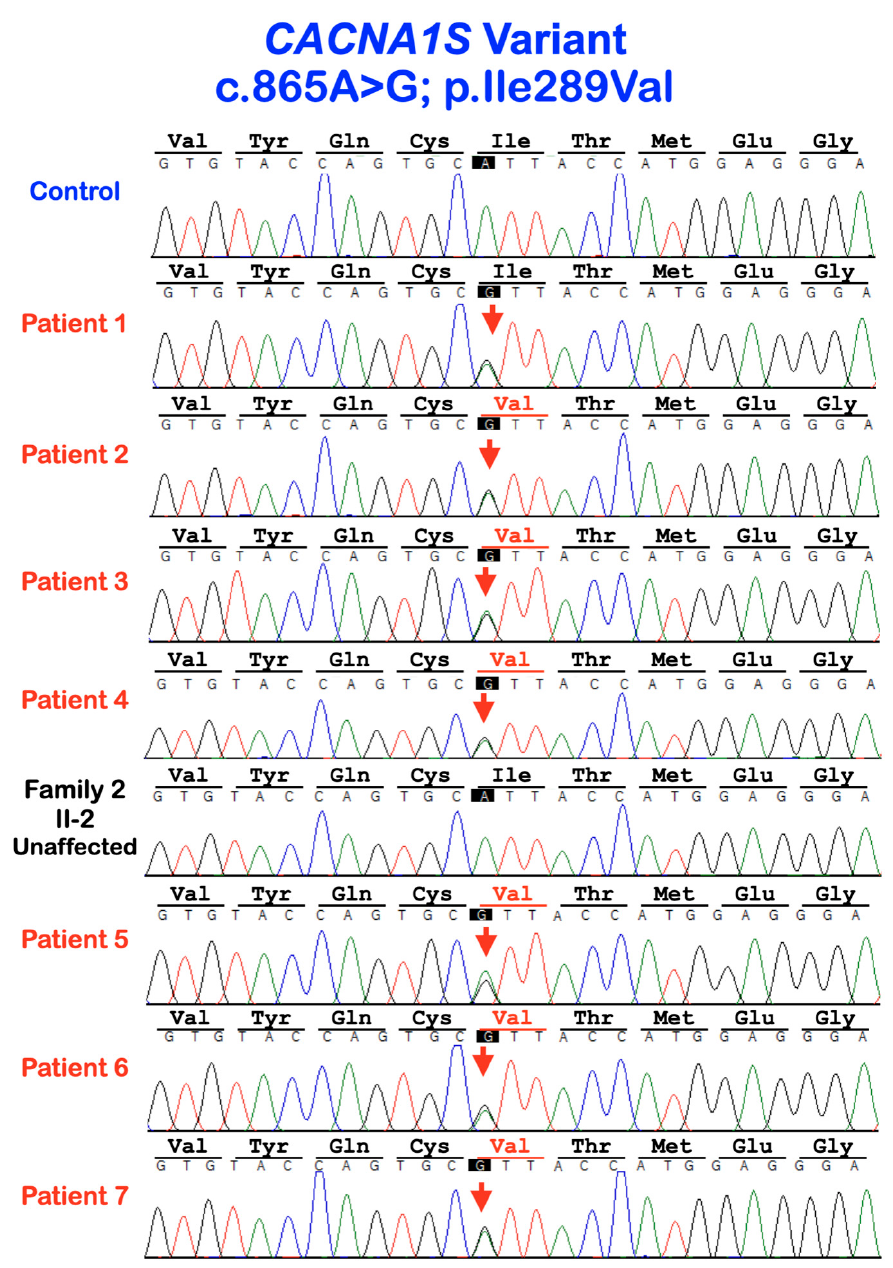
Figure 7. Sequence chromatograms of patients 1–7, the unaffected II-2 of family 2, and a control. The single base substitution from A to G at nucleotide 865 in CACNA1S gene is predicted to cause a change in amino acid isoleucine (Ile) to valine (Val) at amino acid residue 289 (c.865A>G; p.Ile289Val).